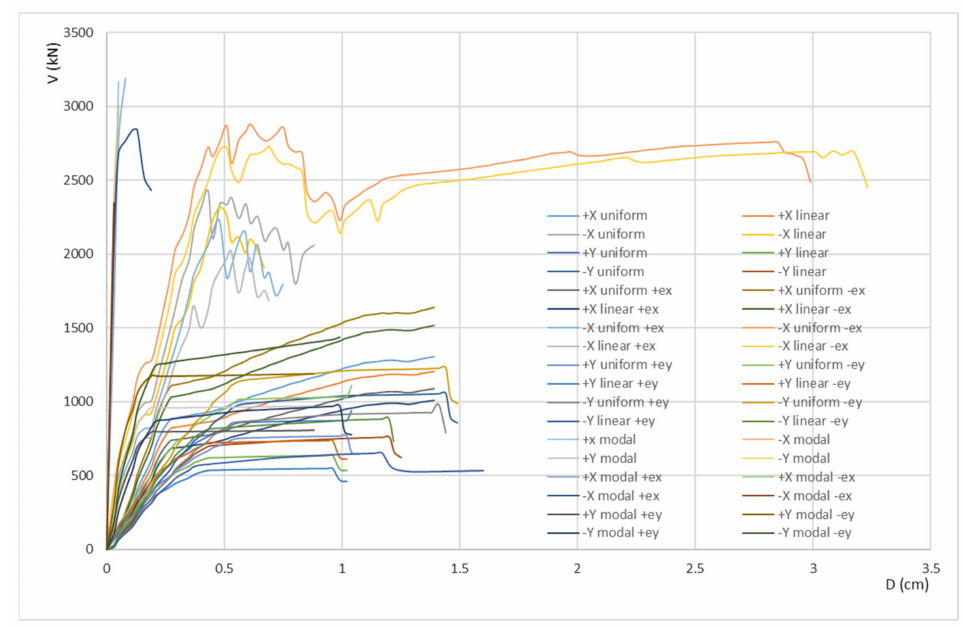
Figure 13. Pushover curves for the Public Library building.